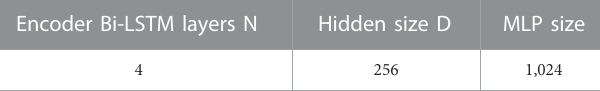
TABLE 3 Details of the fi ne-tuning